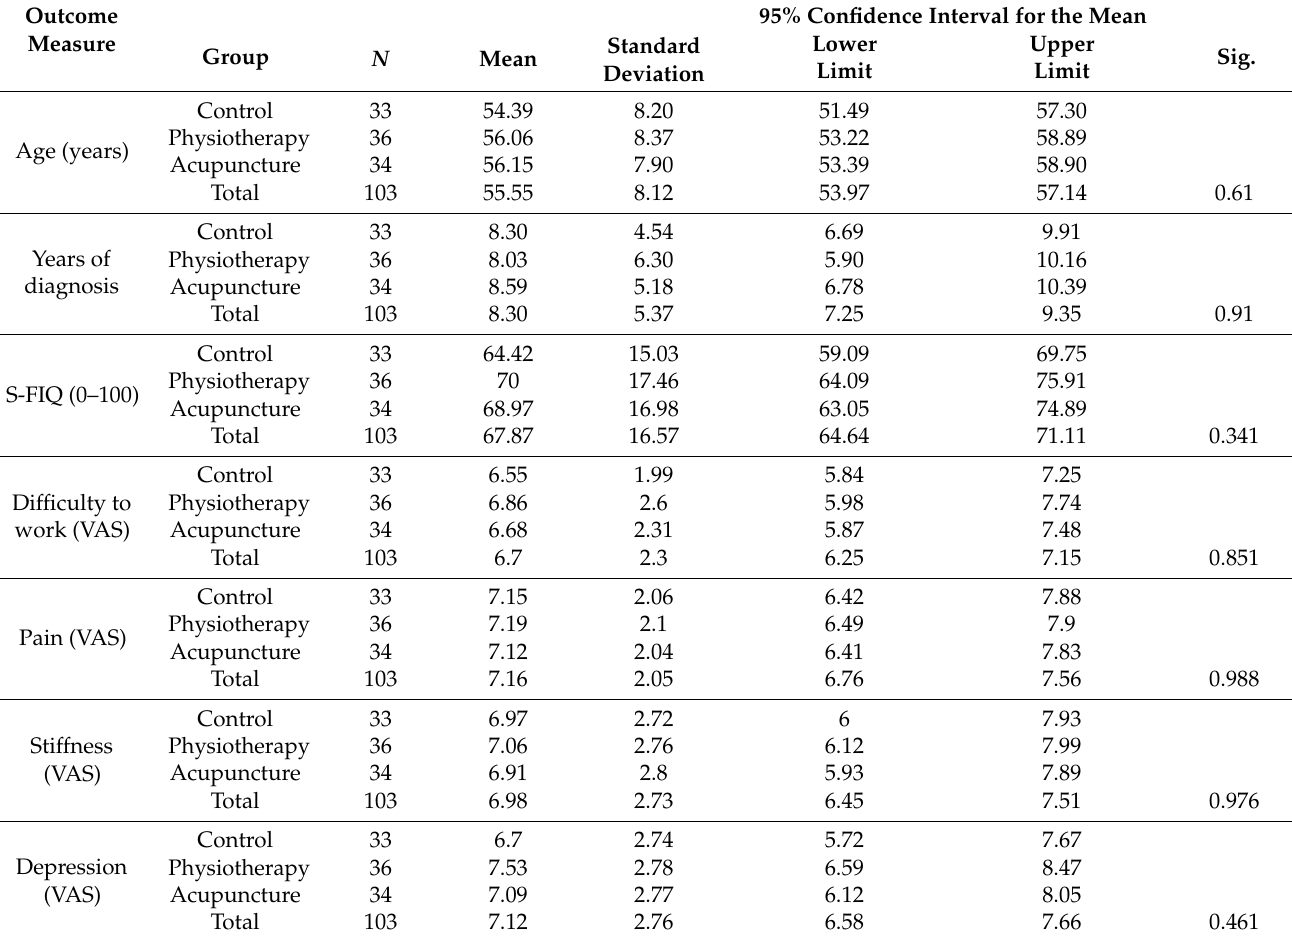
Table 1. Baseline demographic and clinical characteristics of the